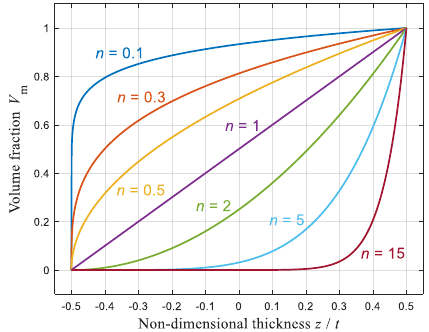
V varies with different n . Figure 2. The volume fraction of the metal V m varies with di ff erent n m